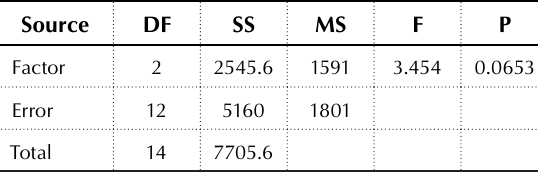
Table 2. ANOVA test results